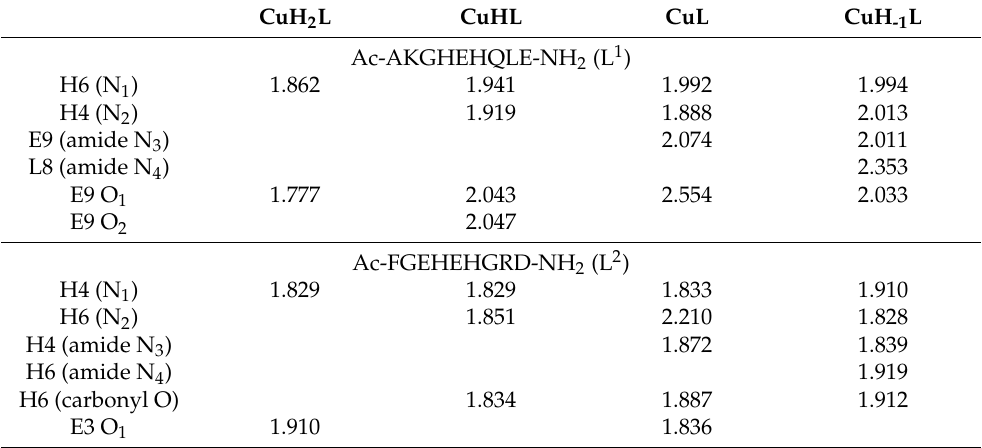
Table 2. Metal-ligand distances in angstroms for Ac-AKGHEHQLE-NH 2 and Ac-FGEHEHGRD-NH 2